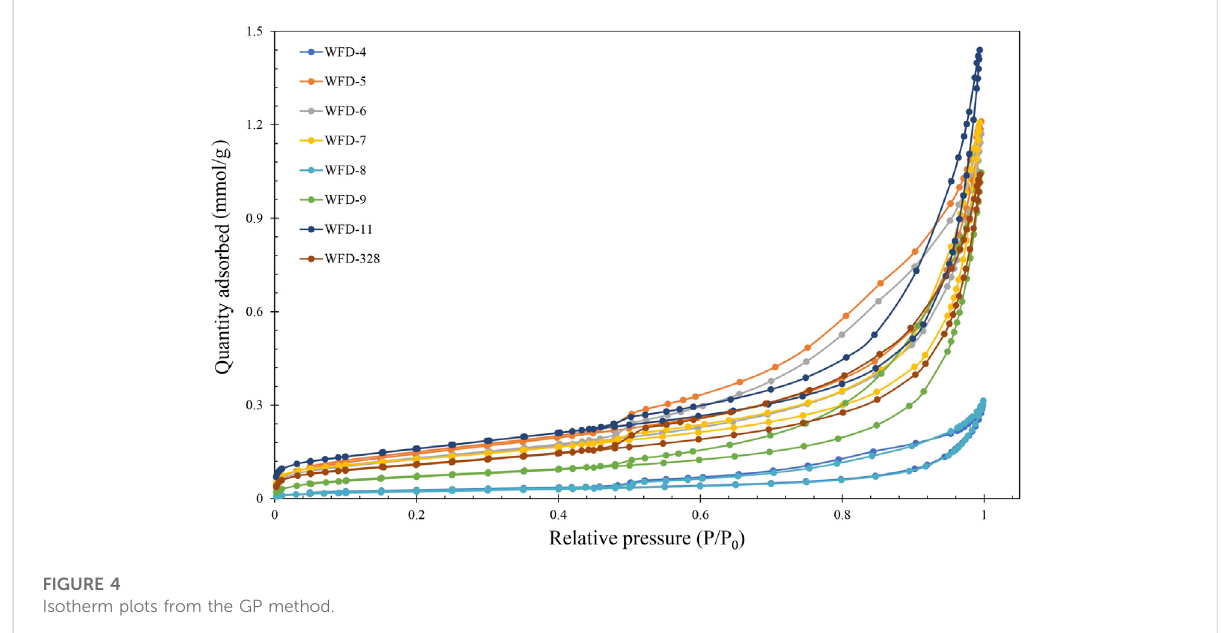
FIGURE 4 Isotherm plots from the GP method.